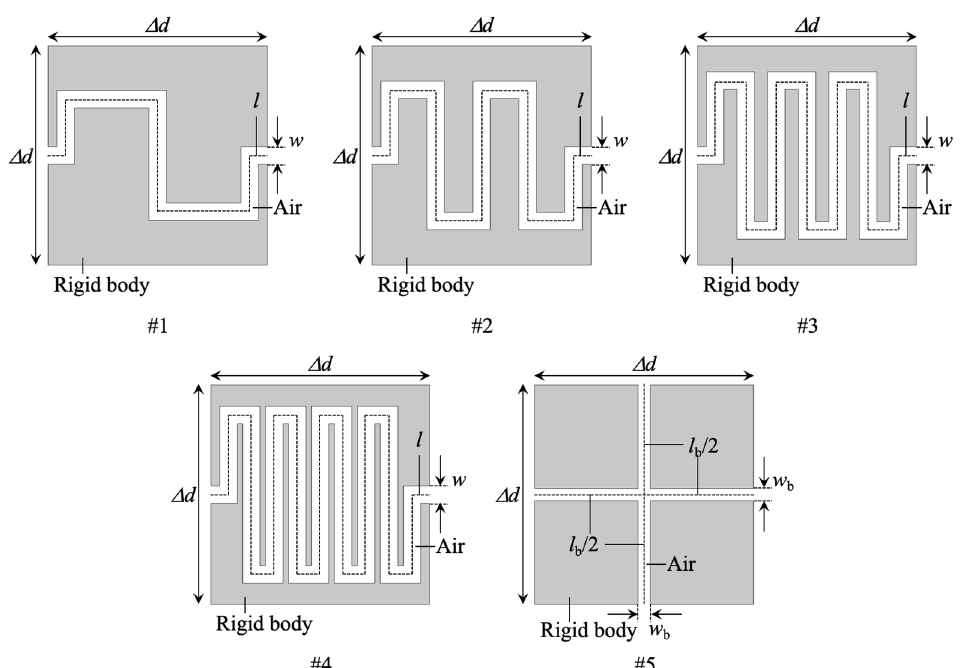
Figure 2. Proposed 1D meander acoustic waveguide structures for the acoustic metasurface (#1–#4) and a 2D straight acoustic waveguide structure for the background medium (#5). w and w b are waveguide widths and l and l b are waveguide lengths. ∆ d is the unit cell length. These waveguides are filled with the air and are formed in the rigid body.